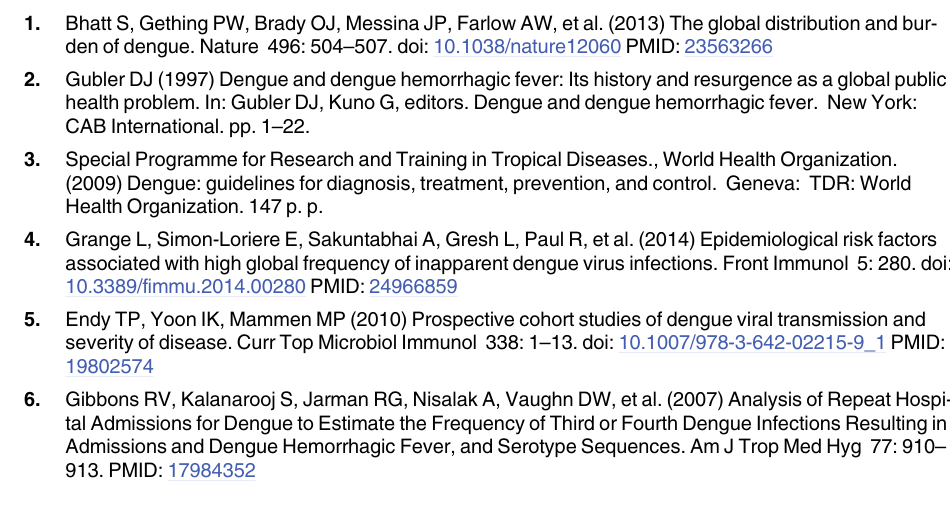
S1 Table. Number of completed acute illness visits and follow up visits 1 after detection of acute febrile episodes (n = 274). S2 Table. Clinical presentation of symptomatic dengue virus (DENV)